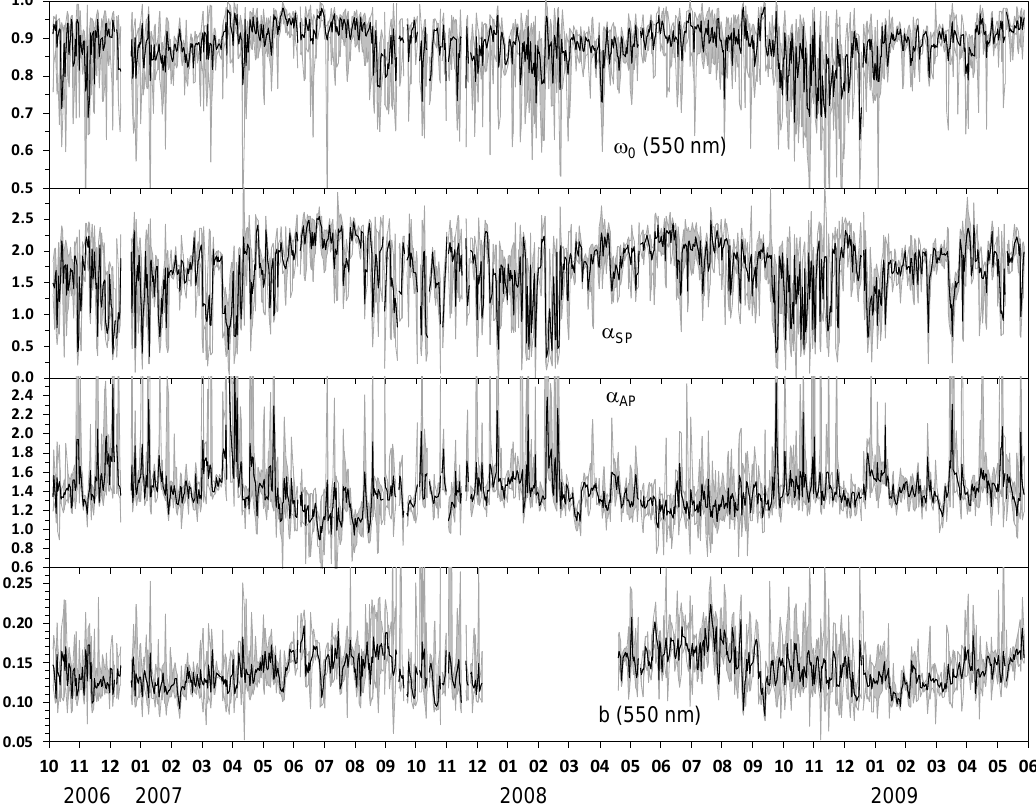
Fig. 3. Selected intensive aerosol properties at SMEAR II in October 2006–May 2009: Single-scattering albedo ω 0 ( λ = 550nm), ˚Angstr¨om exponent of absorption, α AP ( λ =470–950nm), ˚Angstr¨om exponent of scattering α SP ( λ =450–700nm), and backscatter fraction, b ( λ = 550nm). Black line: daily median; the gray shaded area: the 95percent range (2.5th and 97.5thpercentiles) of the hourly-averaged data in each